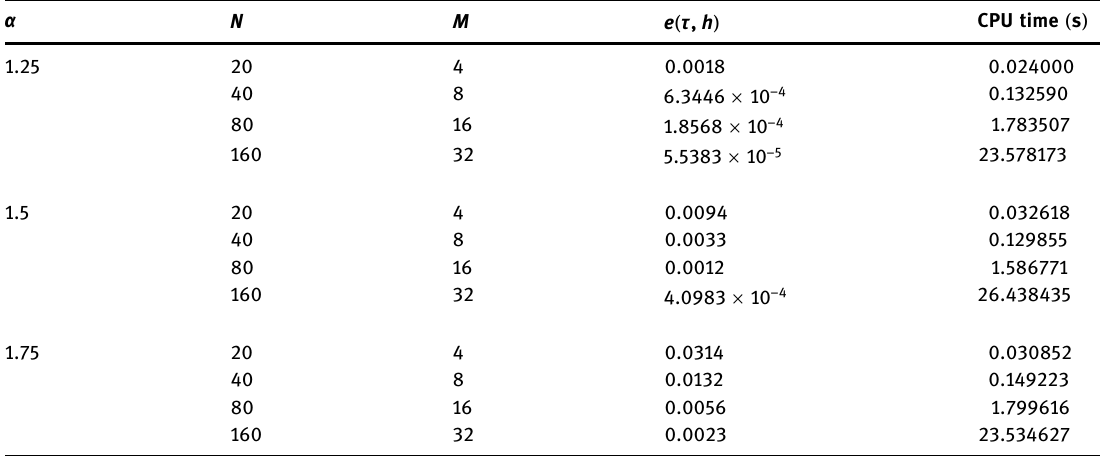
Table 2: Maximum norm error and CPU time of the proposed scheme for Example 1